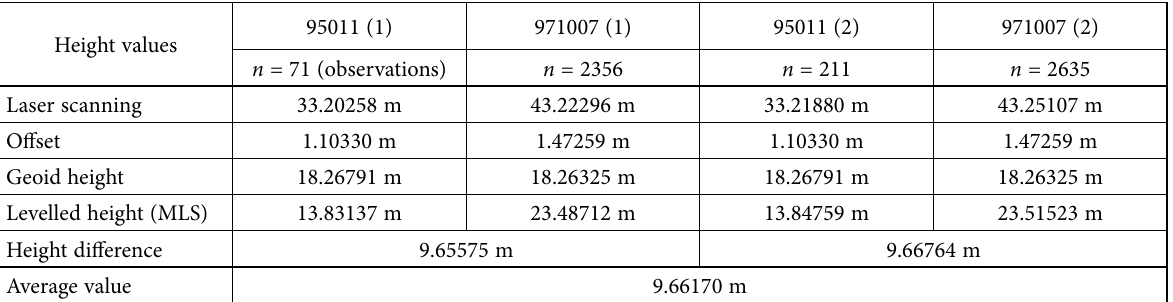
Table 7. Results of the MLS measurements